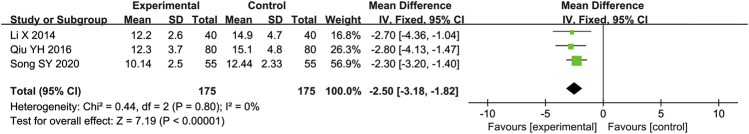
Forest plot of E/e′.